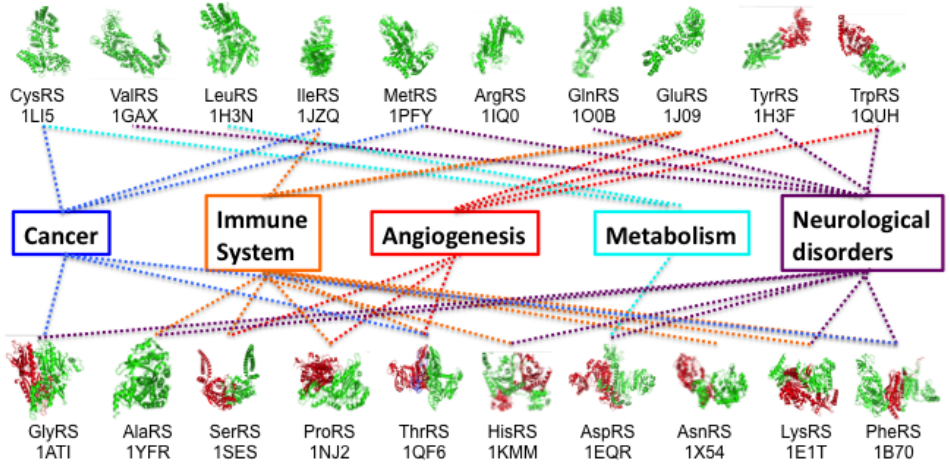
Figure 1. Links between aminoacyl-tRNA synthetases, human physiology and disease suggested by current research. Further details about these specific associations can be found in recent reviews from investigators in the tRNA synthetase field [24,32–34].